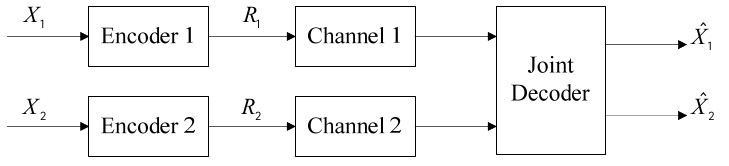
Figure 2. The system model of DJSCC for the independent channels case.